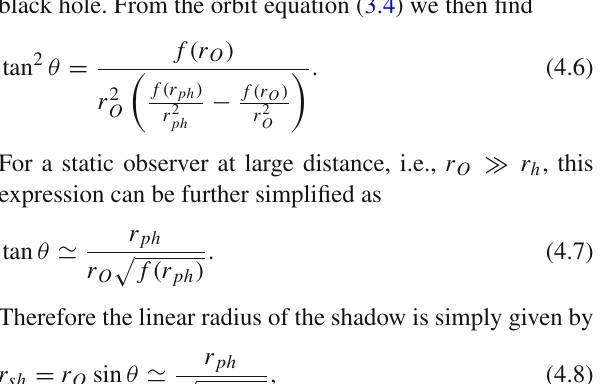
and r ph on the GB coupling constant 3 r h / 2 3 M